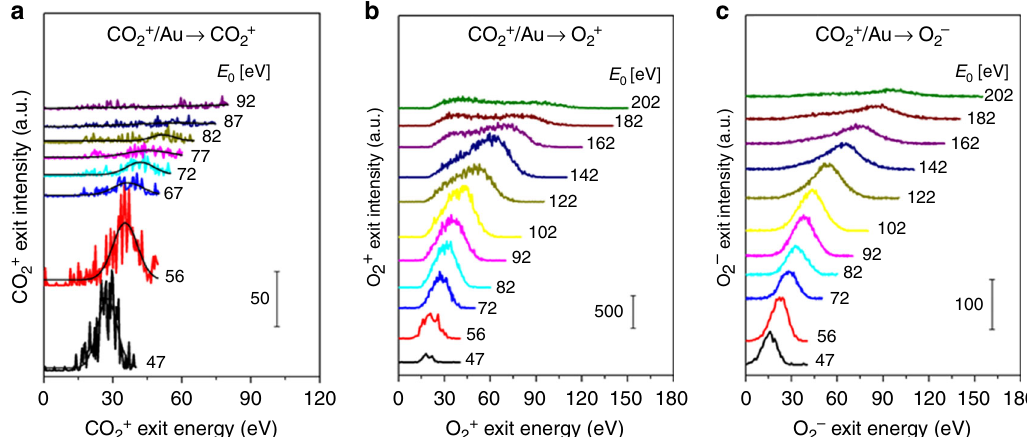
Fig. 1 Dynamic production of O 2 ± in CO 2 + collisions on Au. Scattered product kinetic energy distributions of a CO 2 + , b O 2 + , and c O 2 − ion exits from CO 2 + /Au for various CO 2 + beam energies ( E 0 ) as annotated on each panel. Signal intensities in b and c cannot be compared to each other due to differences in detector bias